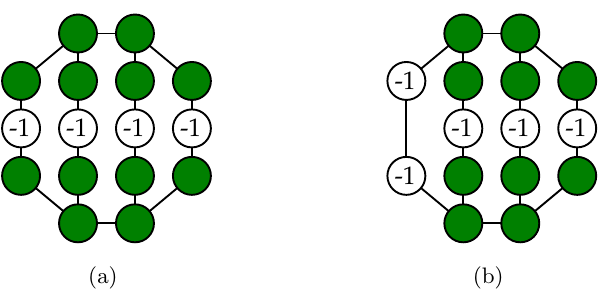
Figure 26 . The marginal CFD for ( D 5 ; D 5 ) minimal conformal matter as determined from the Weierstrass model realizing intersecting ( I (cid:3) the (cid:12)rst descendant by taking a single mass deformation of the marginal